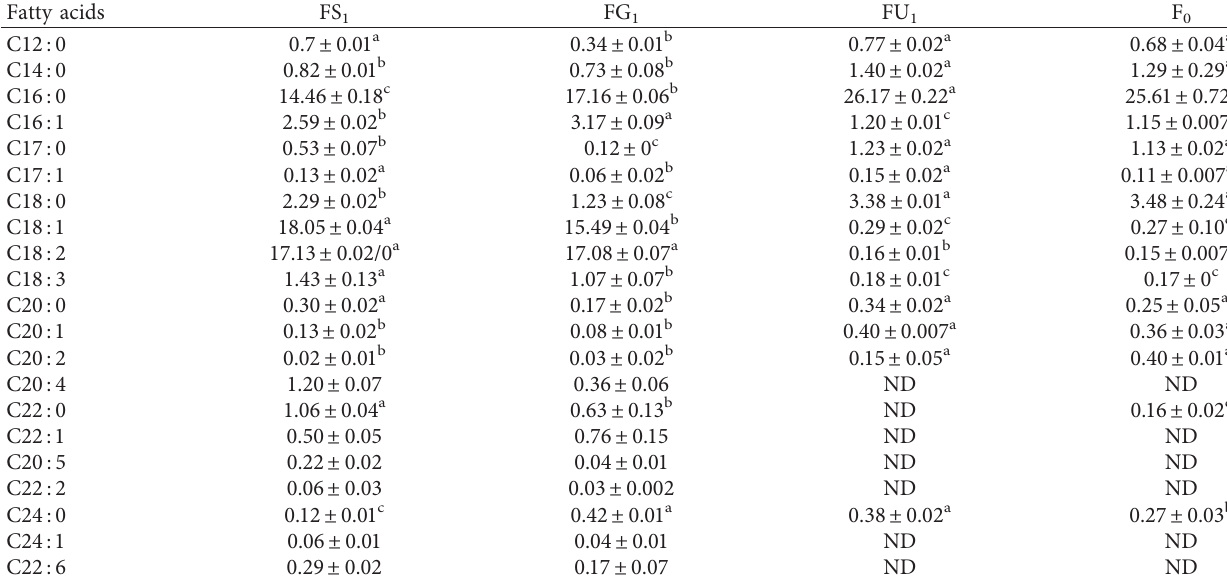
Table 5: Fatty acid profile of sour fruit samples with 1.5% algae